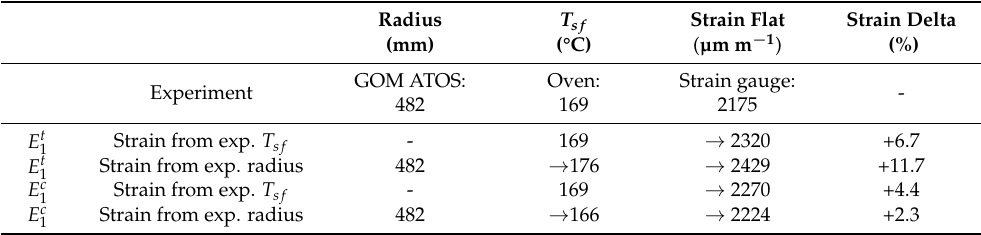
Table 9. Comparison of measured strains (strain gauge) and calculated strains using measured curvature or measured T sf . Values are given for compression and tension moduli of the CFRP material at a reference temperature of T r = 21°C. The strain delta indicates the difference between measured and calculated strains. Right-hand arrows indicate calculated values with the input parameters to their left. Radius T sf Strain Flat Strain Delta (mm) (°C) ( µm m − 1